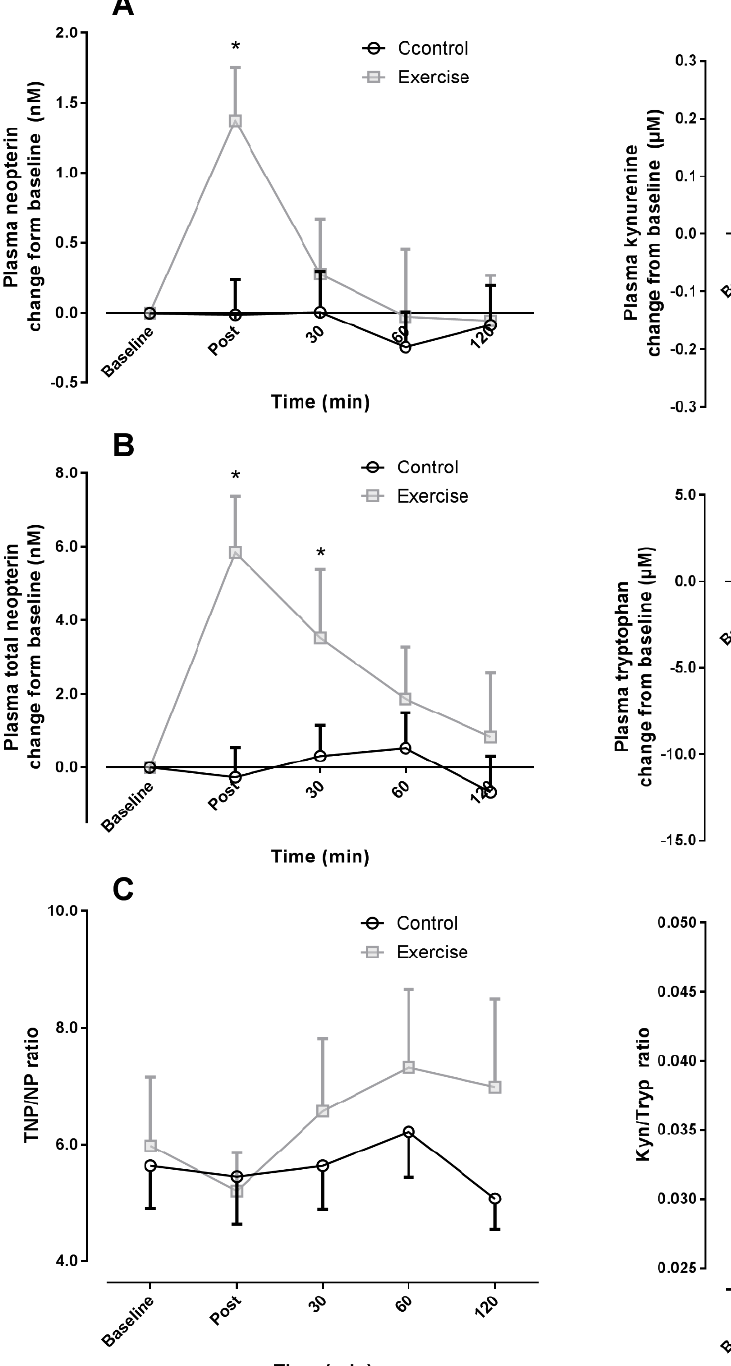
Figure 5: Plasma kynurenine (A) and tryptophan (B) were measured using amine-HPLC and subtracted from baseline values. Kynurenine over tryptophan (Kyn/Tryp) ratio (C) was calculated from unaltered plasma values. There is a small, non-statistically significant, increase in exercise plasma kynurenine versus control at 30 minutes post exercise. Tryptophan decreases for both groups over the study period. The Kyn/Tryp ratio increases for both groups. Data is presented as means with 95%